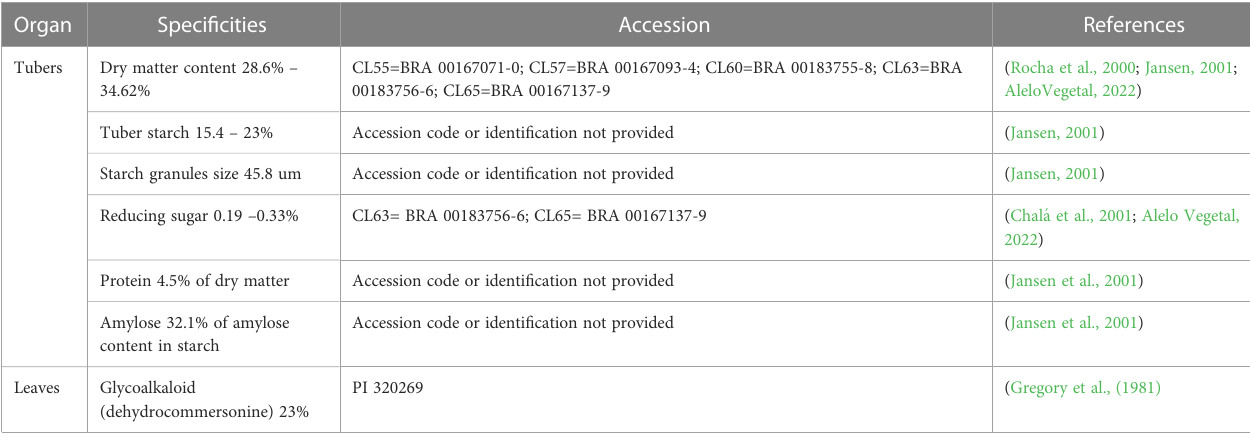
TABLE 4 Quality traits found in potato wild relative Solanum malmeanum (Solanaceae)